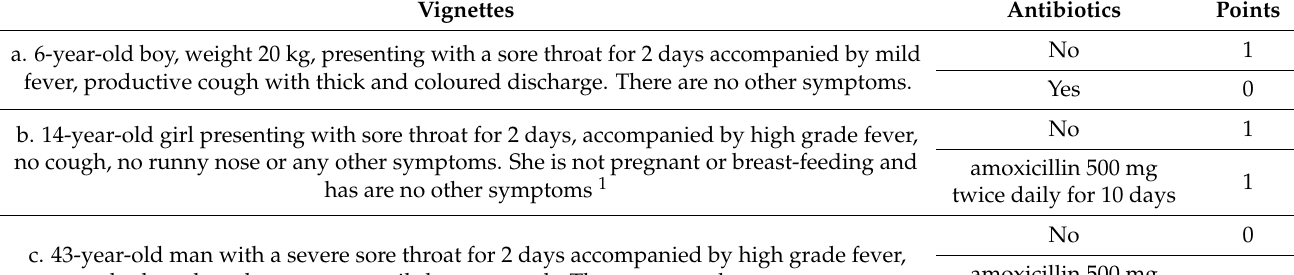
Table 6. Scoring for each vignette to assess the appropriateness of the antibiotic recommendation. Vignettes Antibiotics